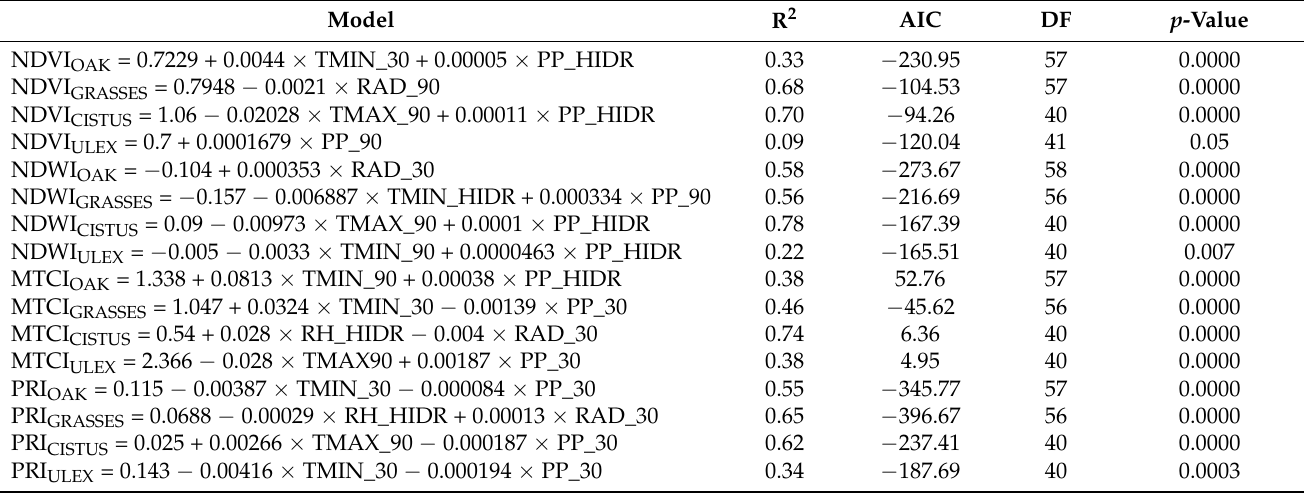
Table 3. Vegetation indices of each generalized linear model (GLM) of the different vegetation type for the 7 years of the study period. For each model, the multiple coefficients of determination (R 2 ), Akaike Information Criterion (AIC), the degrees of freedom (DF) and p -value are given. Model R